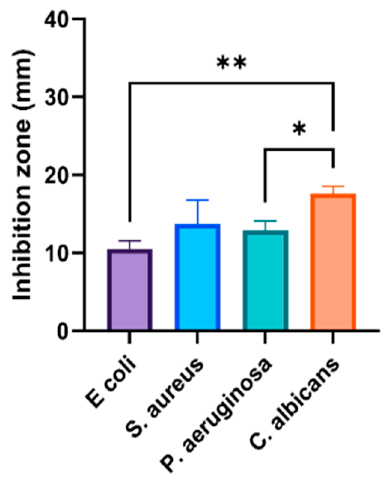
Figure 6. Activity of AgNPs fabricated by O. forsskalii seeds. One-way ANOVA with was performed to identify differences between groups. p < 0.001 (***), p < 0.01 (**).